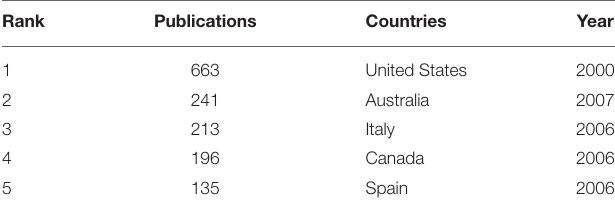
TABLE 4 | Top 5 countries in number of publications related to telerehabilitation. Rank